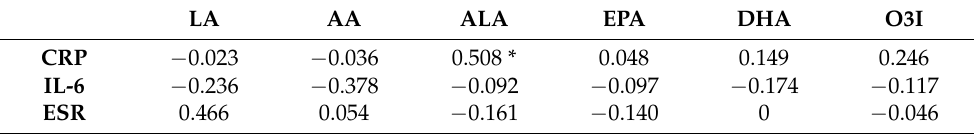
Table 5. Correlations between some relevant fatty acids and biochemical parameters of inflamma- tion. Statistical significance was estimated using Spearman’s non parametric correlation coefficient. * p <